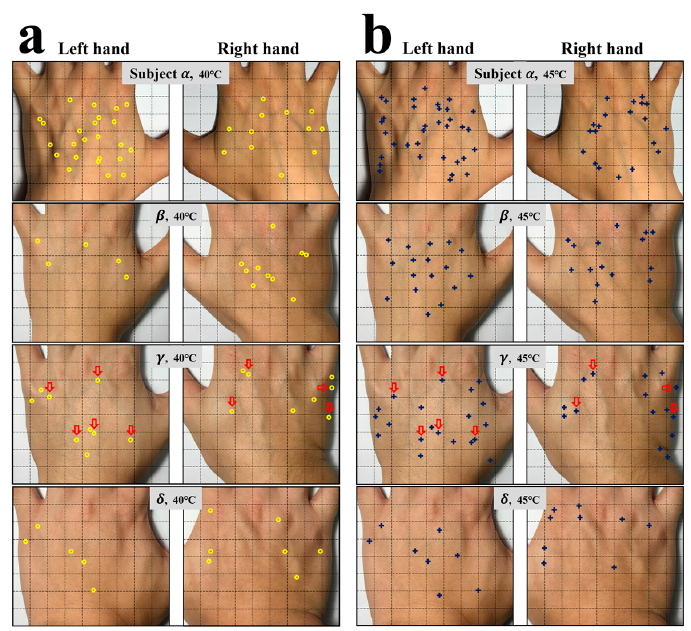
Figure 1. Photographs for the locations of sensory spots on the back of hands of subjects α , β , γ , and δ . ( a ) Yellow circles and ( b ) Blue crosses highlight the locations of sensory spots responded to at 40.0 and 45.0 °C, respectively. Red arrows in ( a , b ) are used to mark the locations of fixed sensory spots responded to at 40.0 and 45.0 °C.